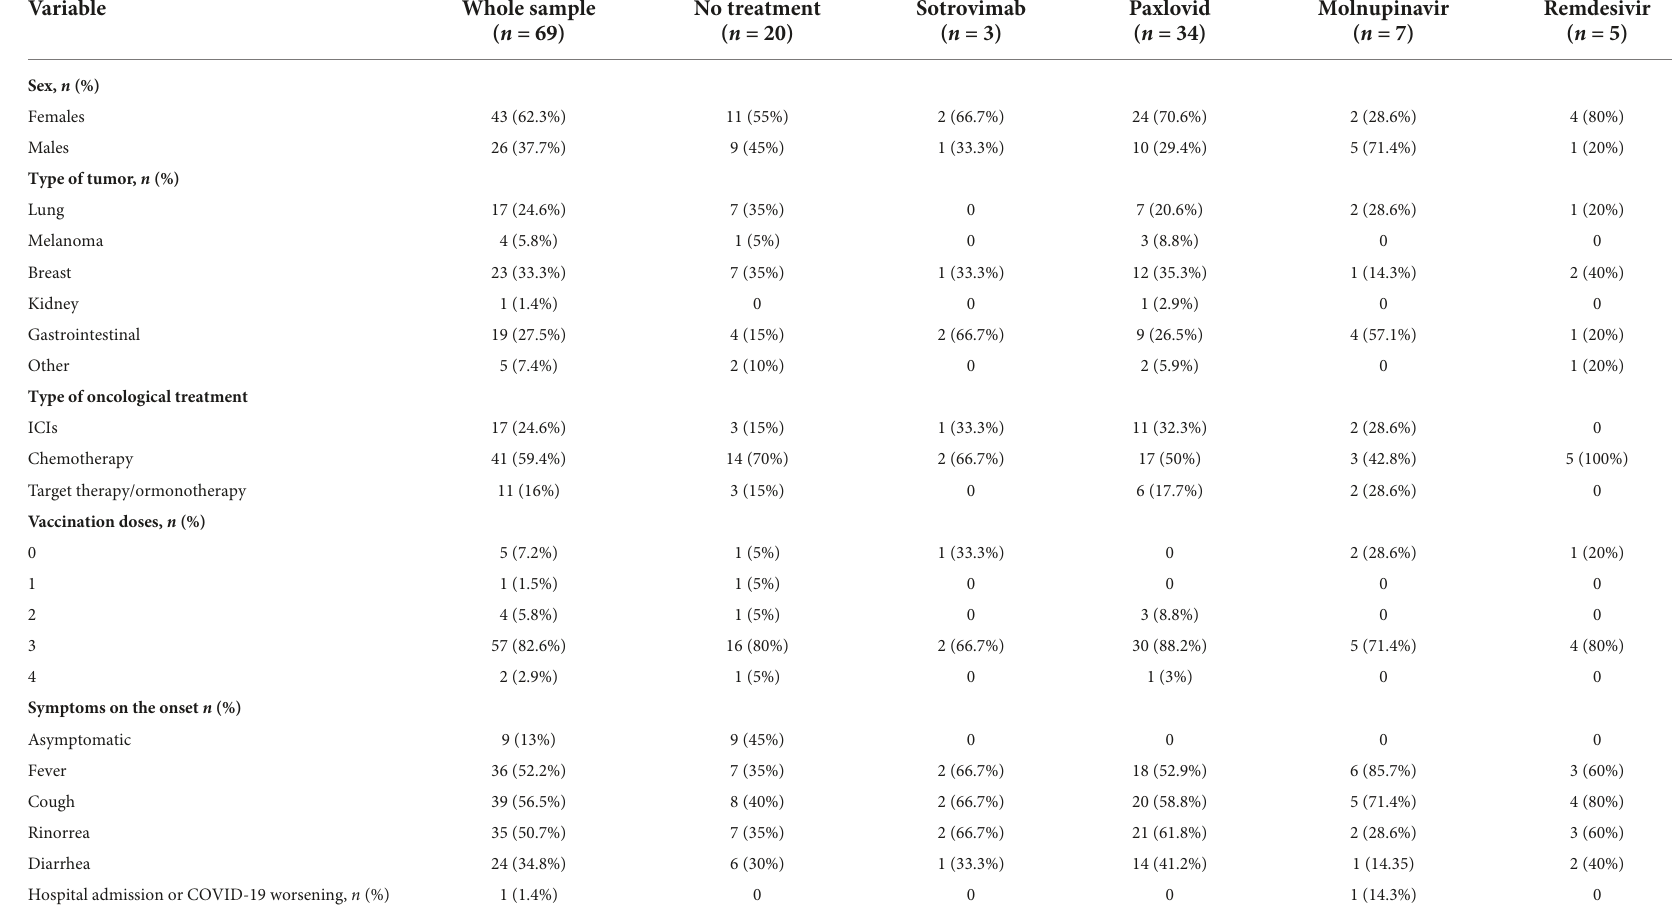
TABLE 1 Demographic and clinical